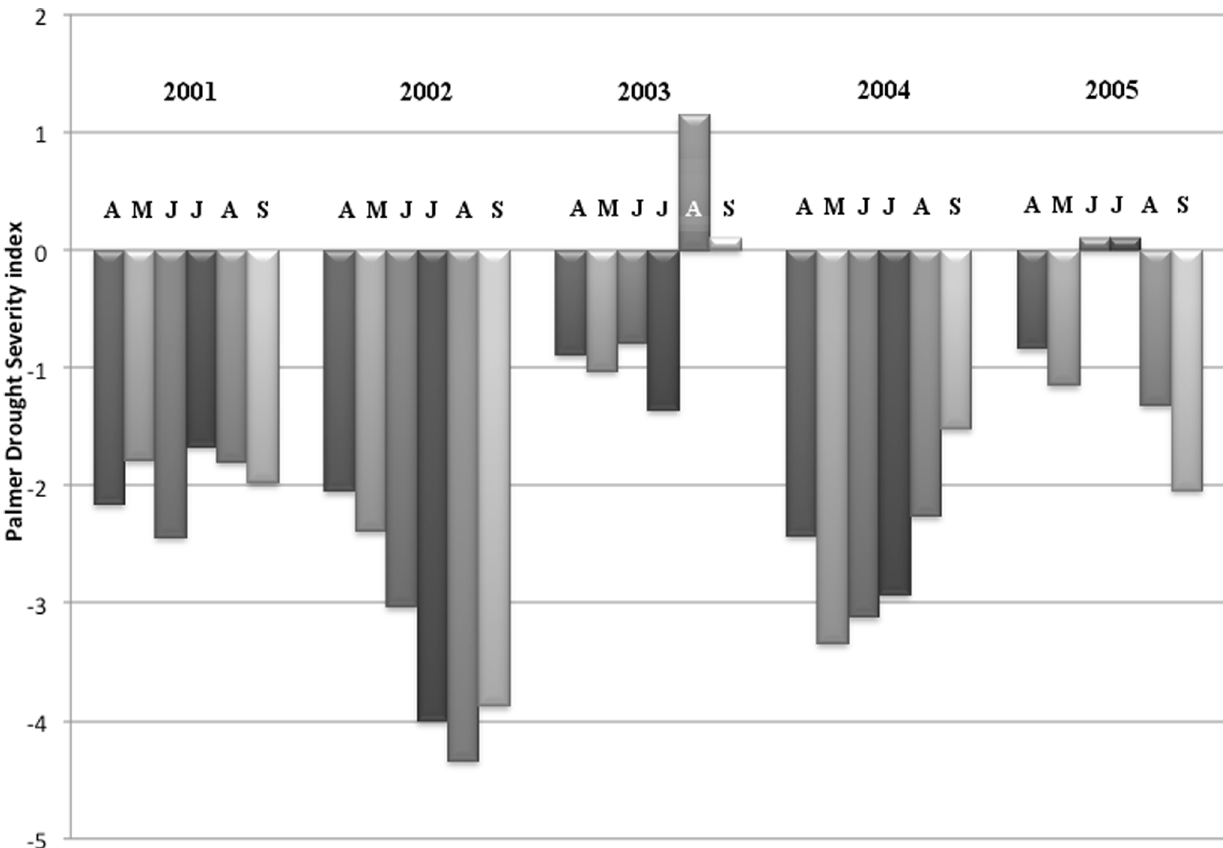
Figure 1. Palmer Drought Severity Index for the spring and summer months in the region including Fort Collins, Colorado, 2001– 2005. Relative monthly drought is indicated by the depth of bars below zero.